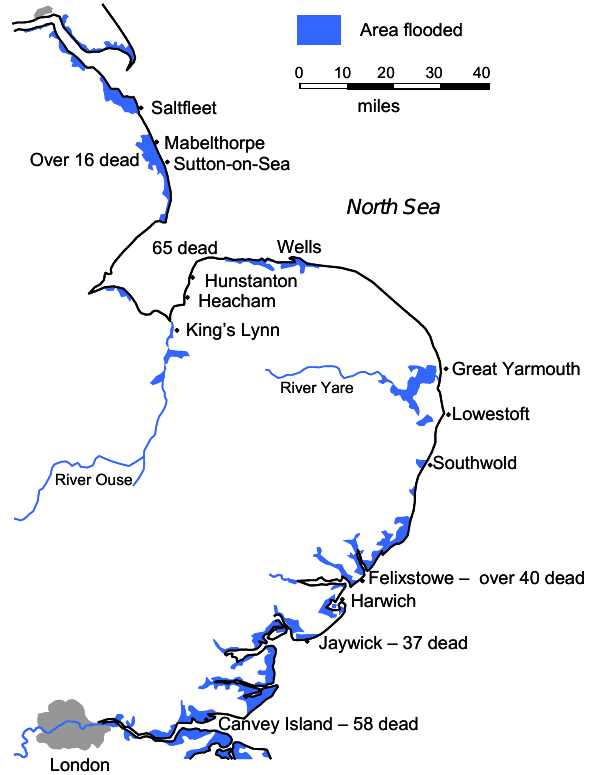
Fig. 2. Typical breach in the flood defences during the 1953 floods. (Sources: Pollard, 1978; and Baxter, 2005).